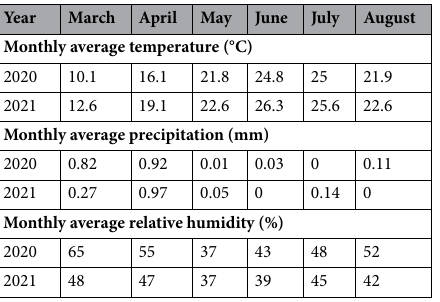
Table 1. Meteorological data from March to July in 2020 and 2021 in the study site at Miandoab, Iran.